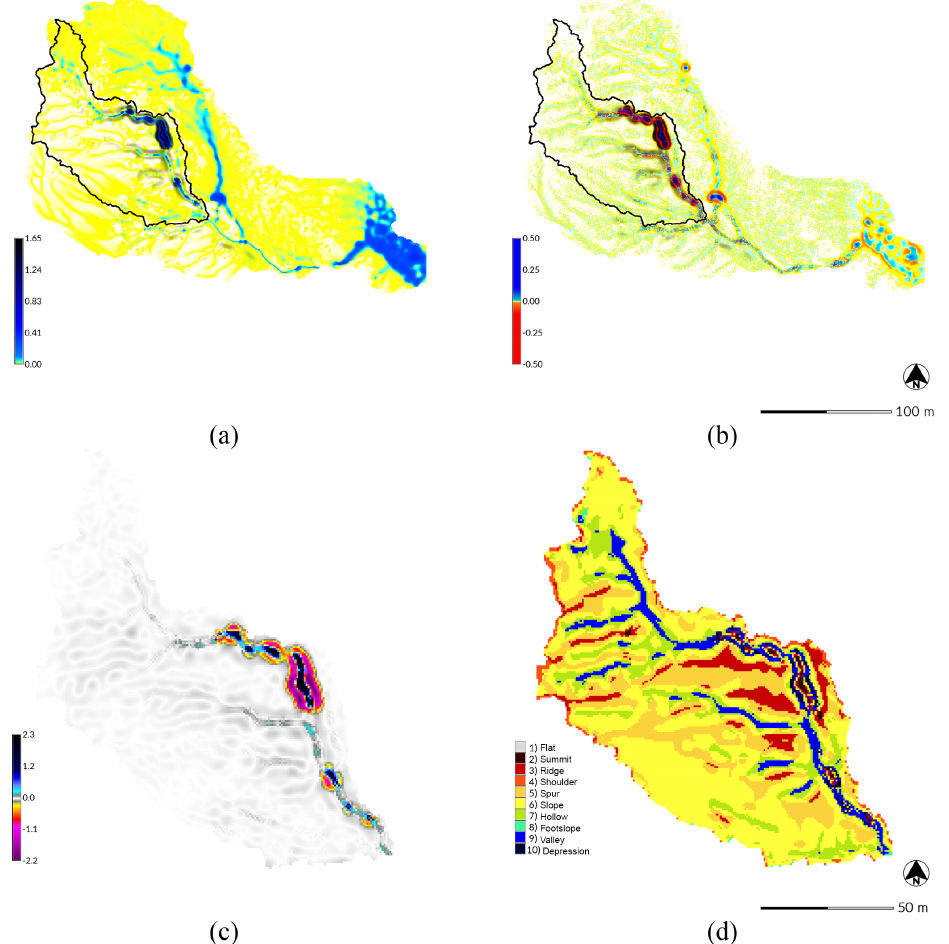
Figure 9. Steady-state SIMWE simulations for a 120min event with a rainfall intensity of 50mmh − 1 for Patterson Branch, Fort Bragg, NC: (a) depth of unsteady flow [m] and (b) erosion–deposition [kgm − 2 s − 1 ] for the subwatershed; (c) net difference [m] and (d) landforms for drainage area